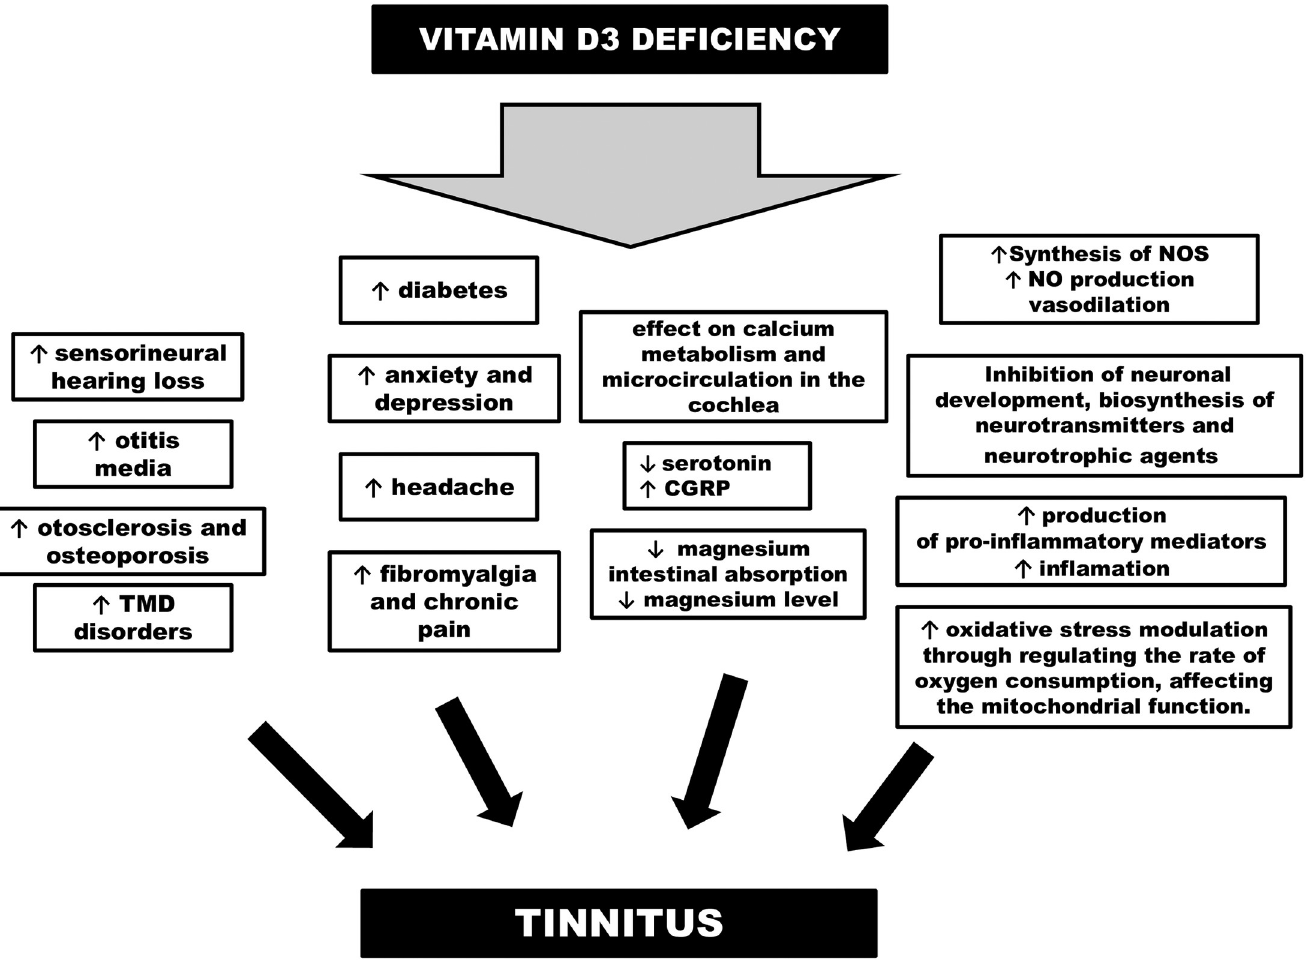
Fig 1. Proposed mechanisms by which vitamin D may influence tinnitus. Abbreviations: TMD temporo-mandibular disorders, CGRP—calcitonin gene-related peptide, NO—nitric oxide, NOS—nitric oxide synthases.